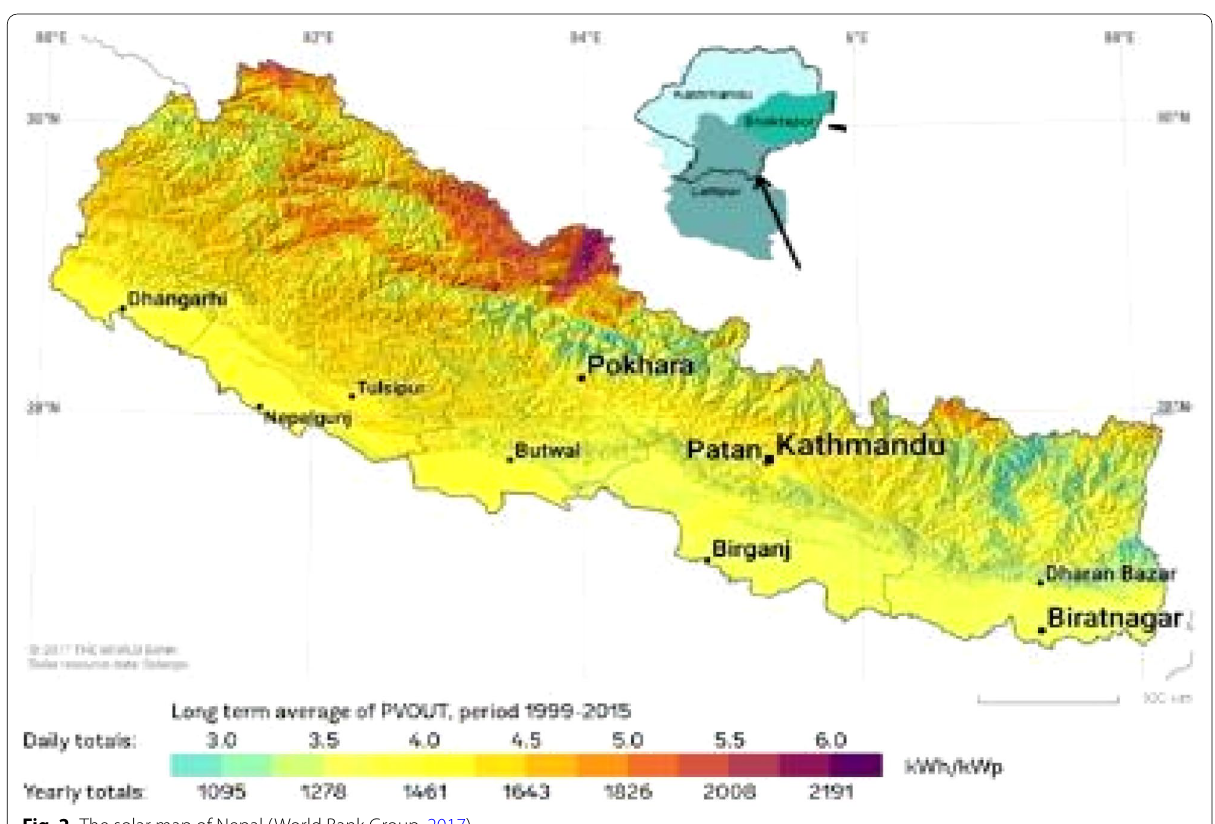
Fig. 2 The solar map of Nepal (World Bank Group, 2017)